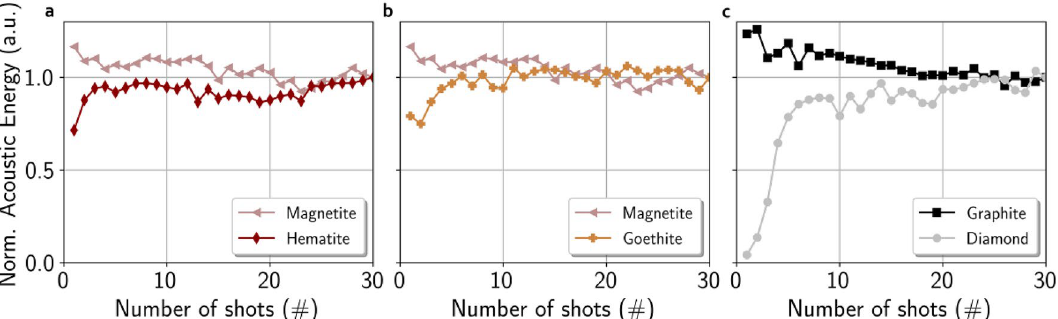
Figure 1. Evolution of the laser-induced acoustic energy over a burst of 30 LIBS shots on three couples of minerals: ( a ) hematite and magnetite, ( b ) goethite and magnetite and ( c ) graphite and diamond. For each target, the acoustic energy is normalized by the value of the last shot of the burst. The increase of the acoustic energy over the first 5 shots which is observed for hematite, goethite and diamond is discussed in the following sections, with regard to a change in laser-matter interaction for these specific